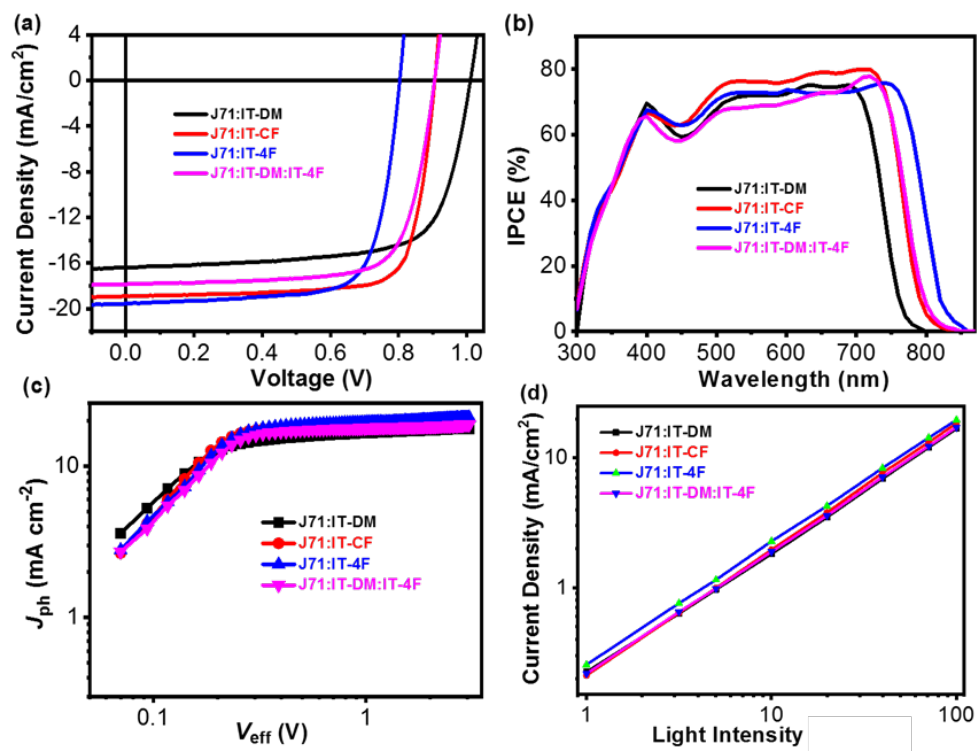
Figure 3. ( a ) J-V Curves of the Optimized Devices; ( b ) IPCE Spectra of the Optimized Devices; ( c ) J ph vs. V eff Curves of the Optimized Devices; and ( d ) J SC vs. Light Intensity of the Optimized Devices.